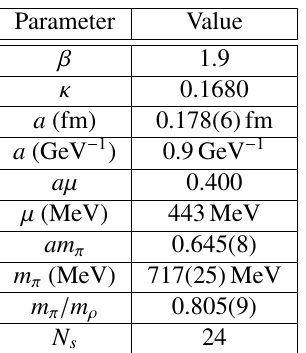
Table 1: Configurations were generated using the above parameters for a coarse lattice as described in